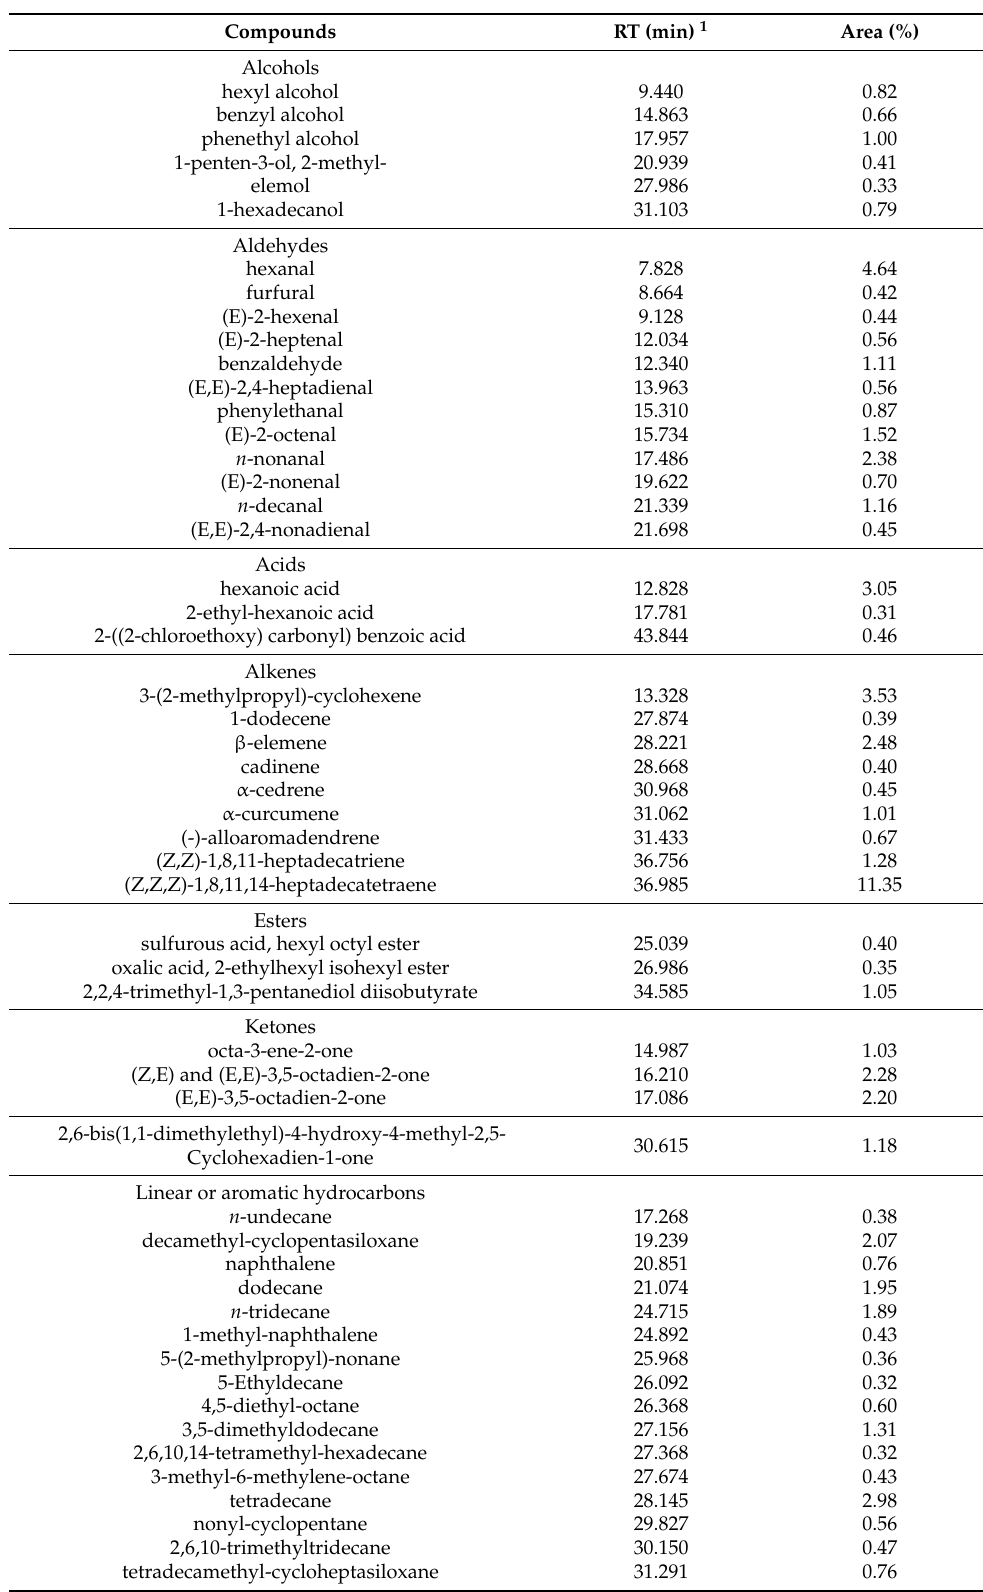
Table 5. Volatile compounds of Fengxian burdock root